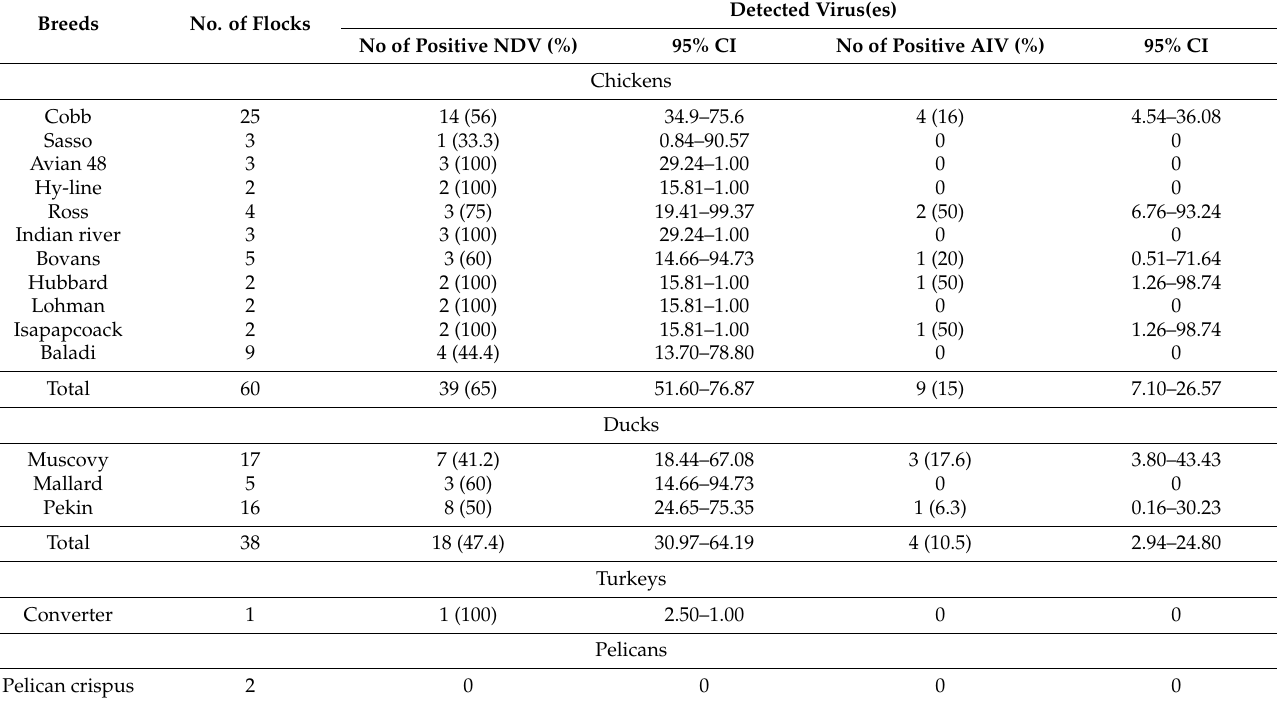
Figure 3. Geographical spread pattern of Egyptian NDV. ( A ) The Egyptian map shows the gover- norates of collected samples (yellow). ( B ) Distribution of tested chicken (red) samples. ( C ) Distribu- tion of tested duck (green), turkey (orange), and pelican (black), samples. ( D ) Distribution of tested wild bird (blue) samples. N/N positive NDV to the total collected samples in each governorate. Table 3. Incidence of NDV among naturally infected domestic birds in Egypt.